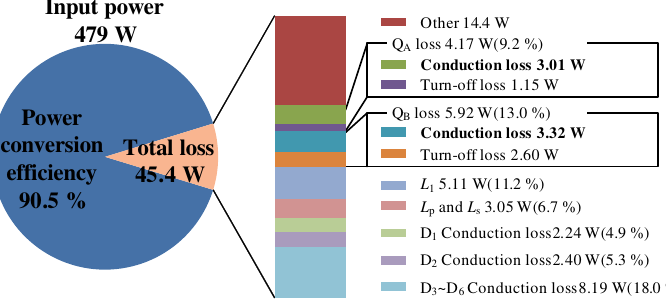
Figure 25. Loss analysis of the LED driver using Si MOSFET DC-DC converters.